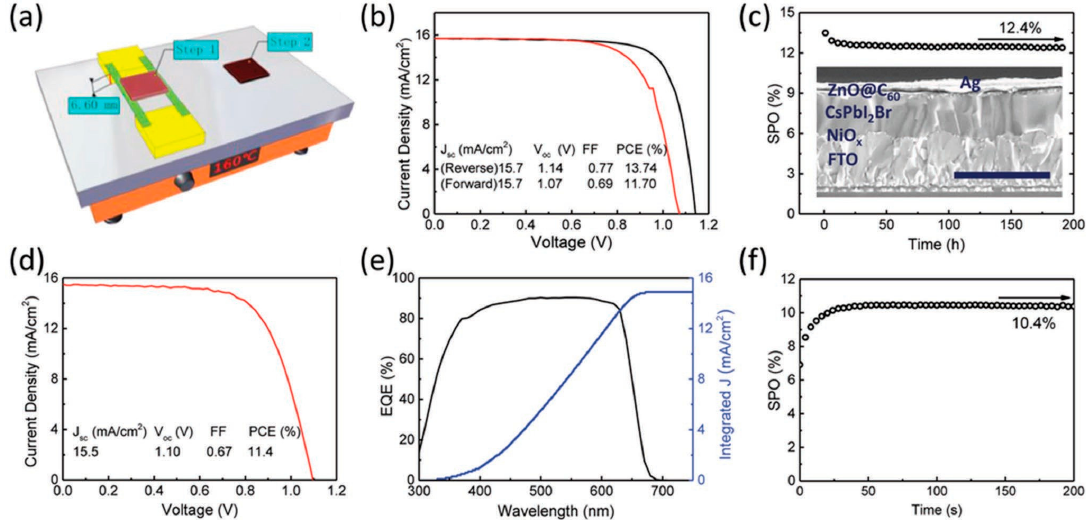
Figure 12. ( a ) Schematic illustration of InCl 3 :CsPbI 2 Br perovskite thin film fabrication via thermal radiation heating method (TRHM); ( b ) J − V characteristics of the champion PSC with an active area of 0.09 cm 2 ; ( c ) SPO at 0.9 V forward bias as a function of time and the corresponding scanning electron microscope snapshot of the PSC with a 1 µ m scale bar; ( d ) J − V characteristics of champion PSC with a larger active area of 1 cm 2 ; ( e ) EQE spectra; and ( f ) SPO at 0.8 V forward bias as a function of time. Adapted with permission from